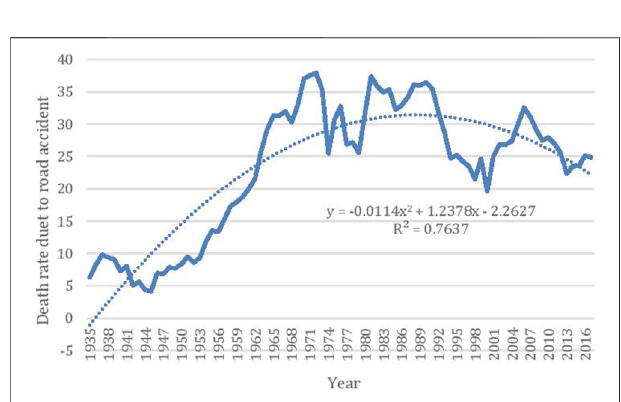
FIGURE 4 | Trends in the death rate due to road accident. Death rate is estimated over 100,000